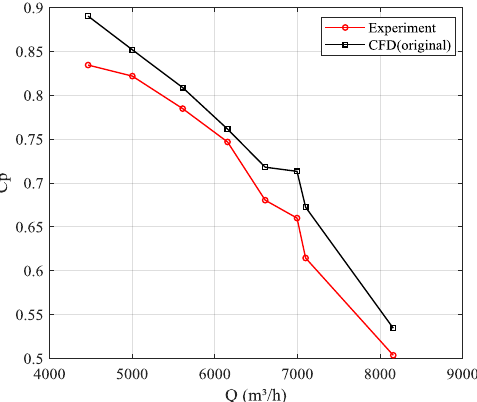
Figure 13. Static pressure coefficients calculated by CFD and the experiment.